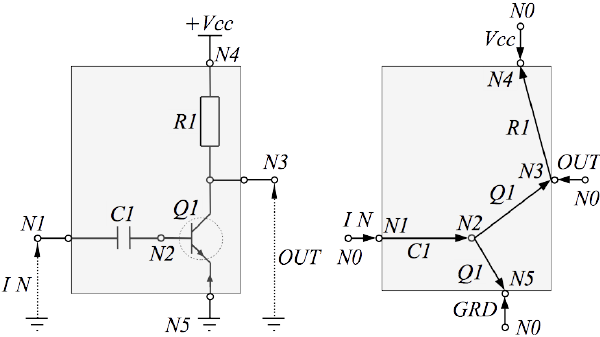
Figure 2. Schematic and corresponding graph of a simple bipolar-junction transistor (BJT) amplifier with feedback. The grey part corresponds to the components, and the outer elements correspond to the external ports, or sources (as in Table